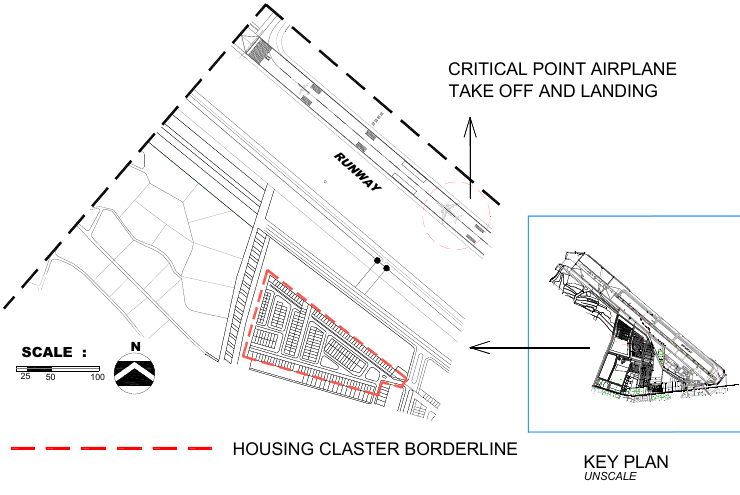
Figure 2. Location of the housing cluster near the runway.